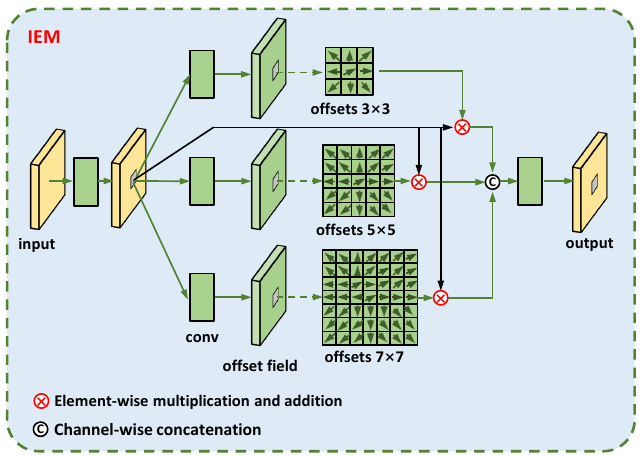
Figure 8. Detailed IEM design of the